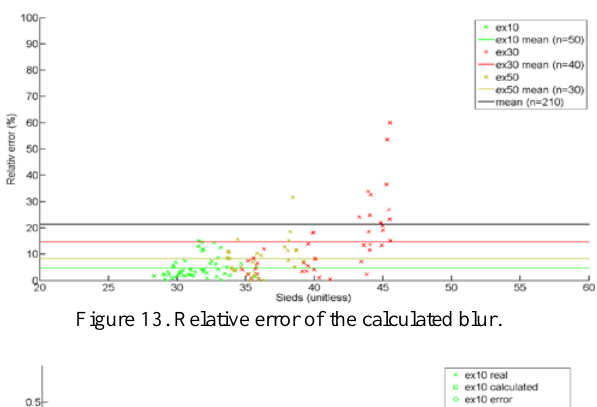
Figure 13. Relative error of the calculated blur.